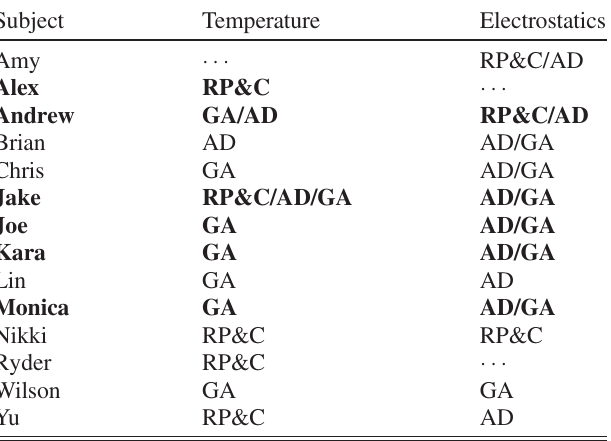
ipants. RP&C stands for recursive plug-and-chug ; GA stands for graphical analysis ; and AD stands for analytical derivation . A slash (/) in between two games in a column means that the subject changed games partway through the task, often when the interviewer asked for an alternate solution. Bolded rows indicate participants with excerpts in the text. Dots ( (cid:3) (cid:3) (cid:3) ) indicate cases where the problem was not attempted by the